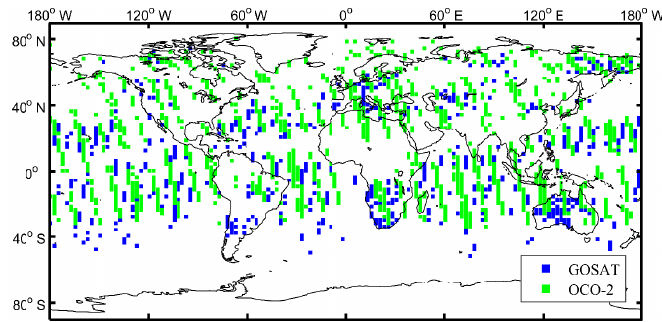
Figure 2. Map of the data coverages of GOSAT and OCO-2 within the first three days in July 2015.